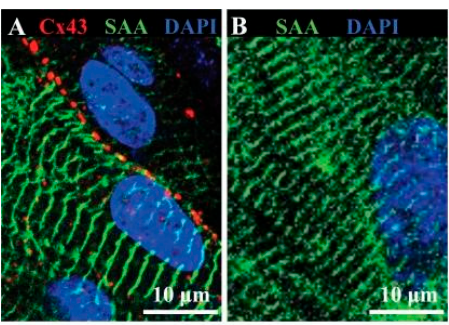
Figure 3. Representative immunostainings of hESC-CMs in 3D patches ( A ) and 2D monolayer ( B